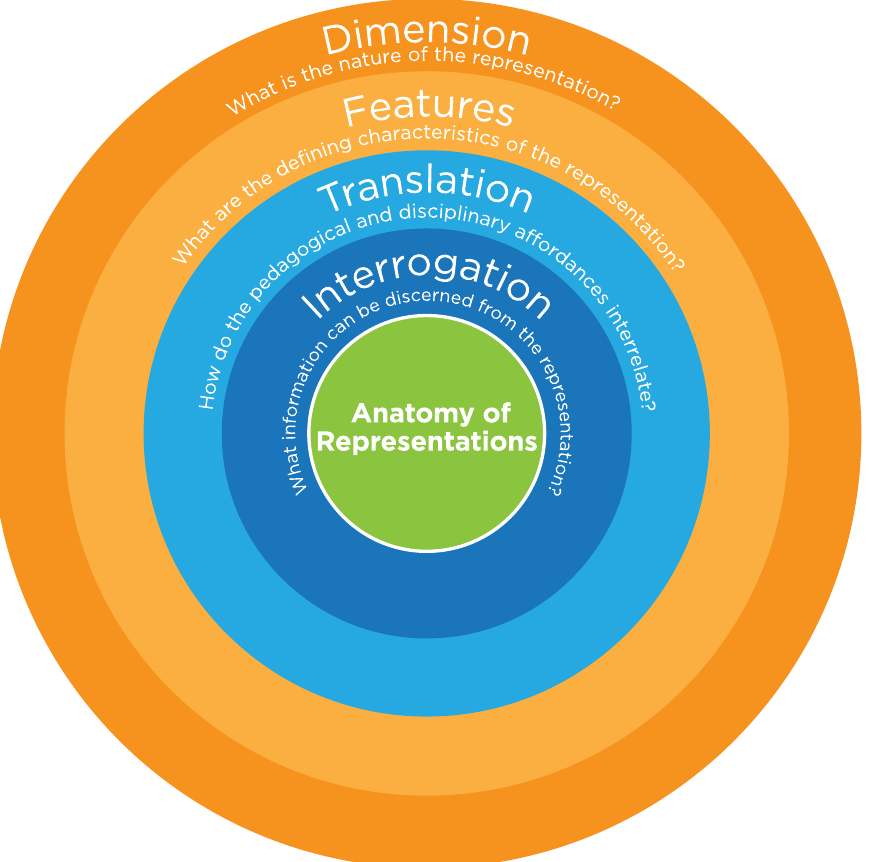
FIG. 12. The anatomy of representations theoretical framework. The reader begins at the outermost layer and gradually works their way to the core. The coloring indicates that the first two layers are related to categorization of representations (oranges), while the inner two layers are a deeper exploration of representations (blues). An interactive version of this is available at https://www